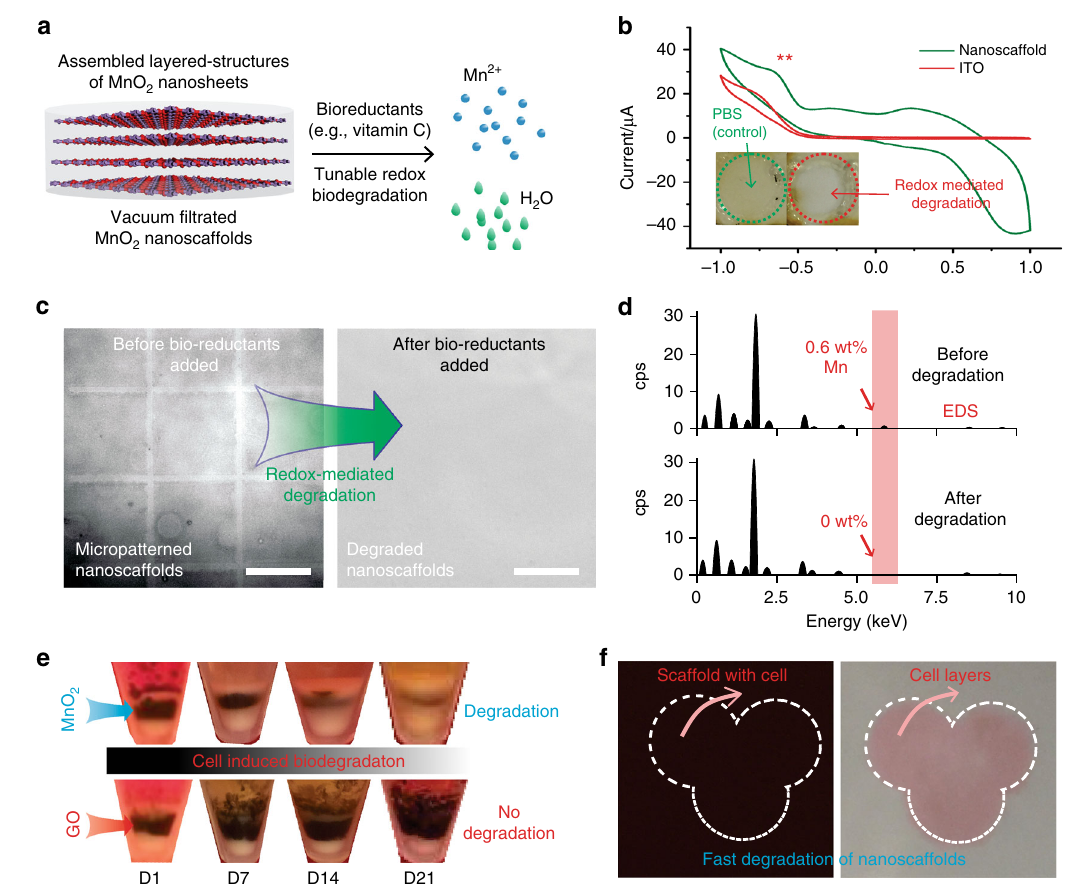
Fig. 3 Controllable biodegradation of MnO 2 hybrid nanoscaffolds. a A schematic diagram explaining an unconventional redox biodegradation mechanism